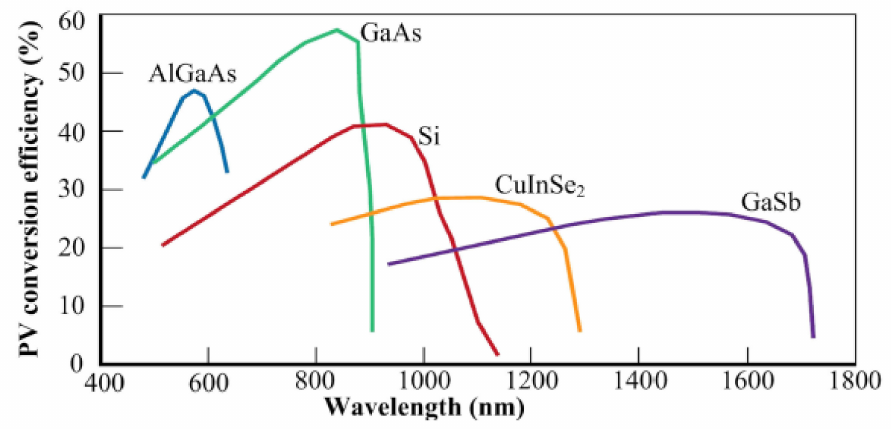
Figure 11. Spectral response of PV materials